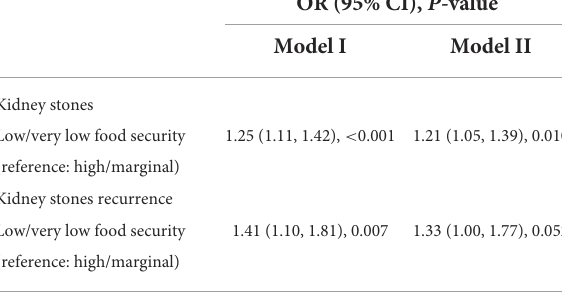
TABLE 3 Association between food insecurity and kidney stones in NHANES